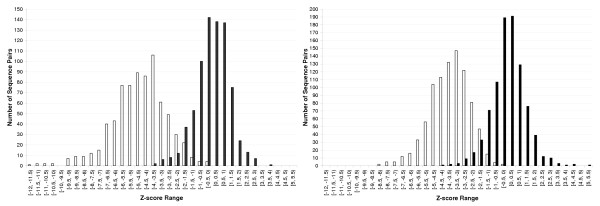
Distribution of sequence pair z scores for 5S rRNA, tRNA, and negative sequences. Distribution of z scores computed using the Dynalign ΔG°total and the columnwise shuffle control method (M = 8) for 5S rRNA sequence pairs and negatives generated from them (left figure) and tRNA sequence pairs and negatives generated from them (right figure). Real ncRNA are white, negatives are black. Test set is the same as for Figure 3.